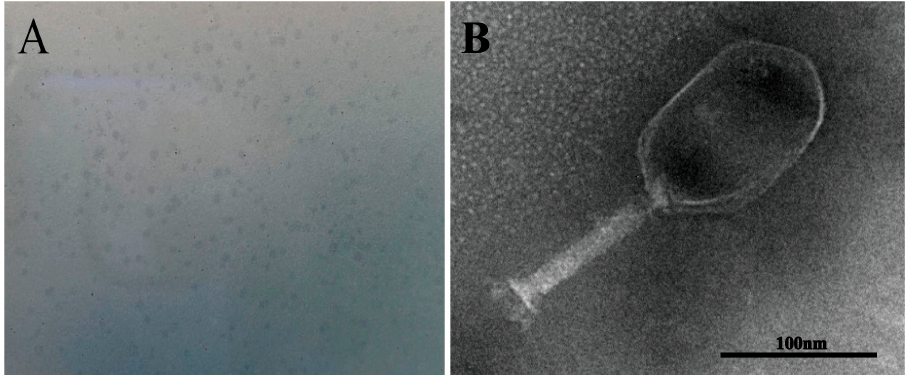
Figure 3. Phage plaques and transmission electron microscopy of phage PVA23. ( A ) Phage plagues of PVA23 formed on double-layer agar plate; ( B ) Transmission electron microscopy of PVA23, scale bar = 100 nm.